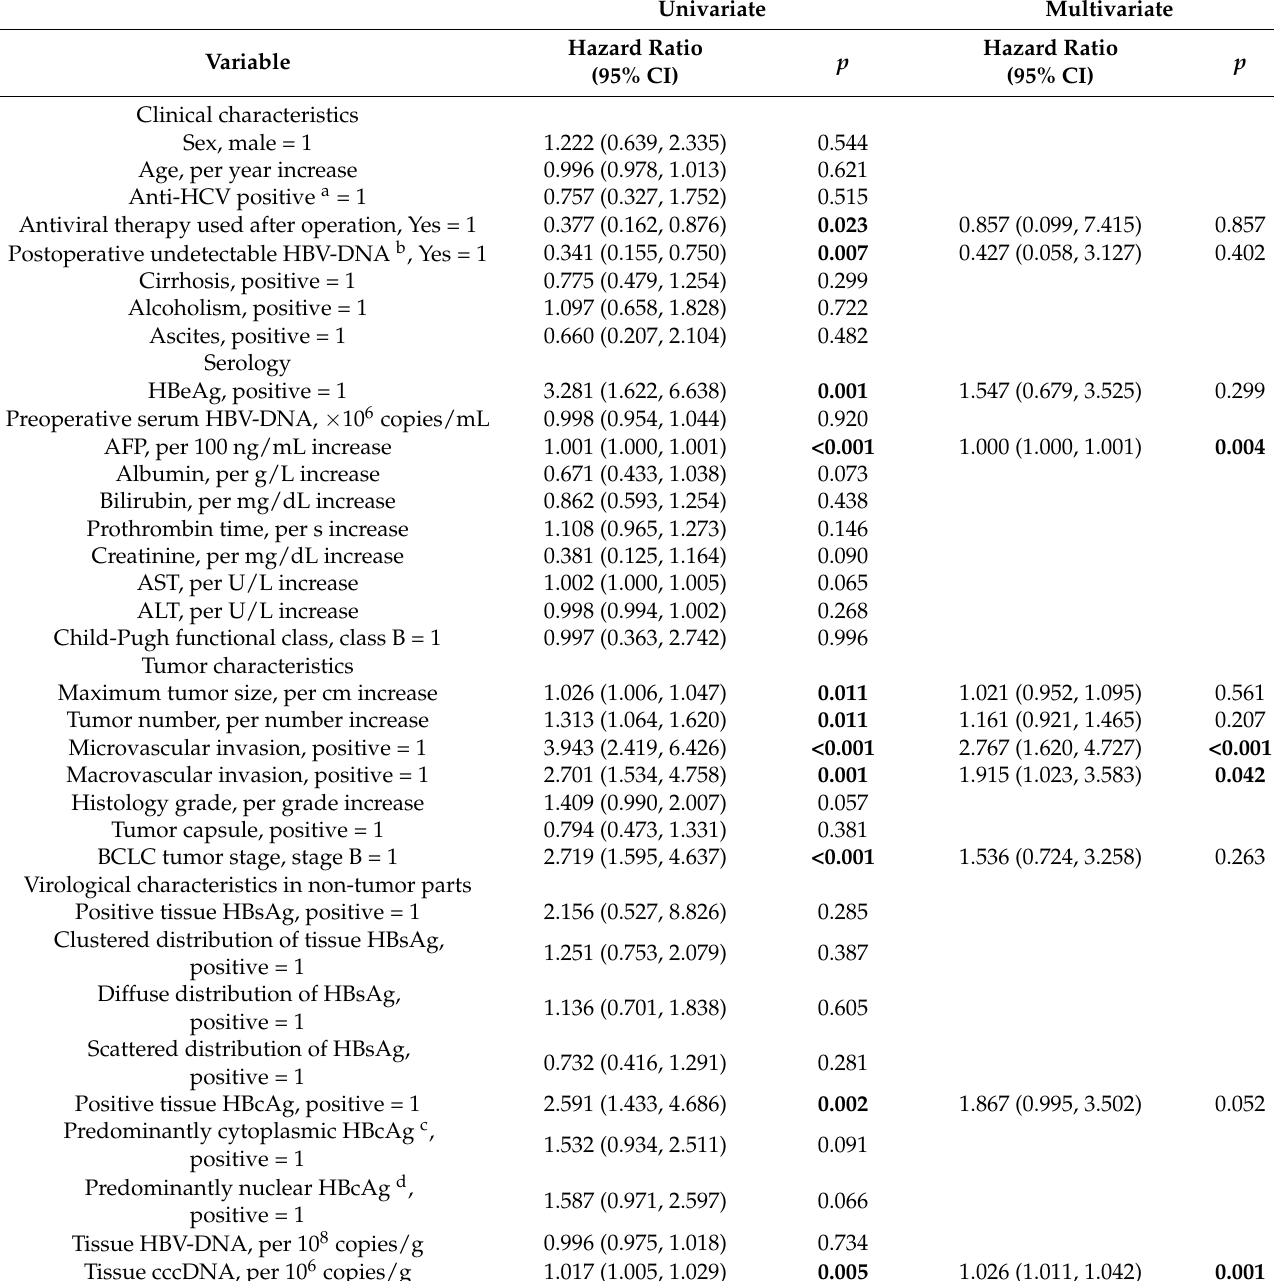
Table 5. Cox proportional hazard analysis for clinicopathological and virological parameters in relation to distant metastasis free